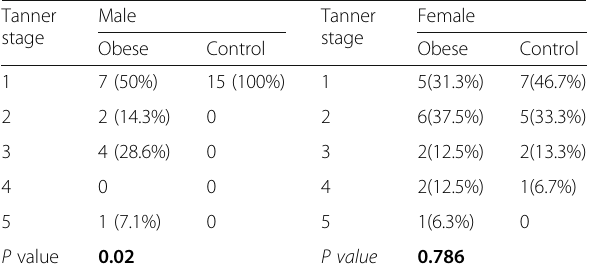
Table 1 Comparison of Tanner stages in males and females between obese and control Tanner stage